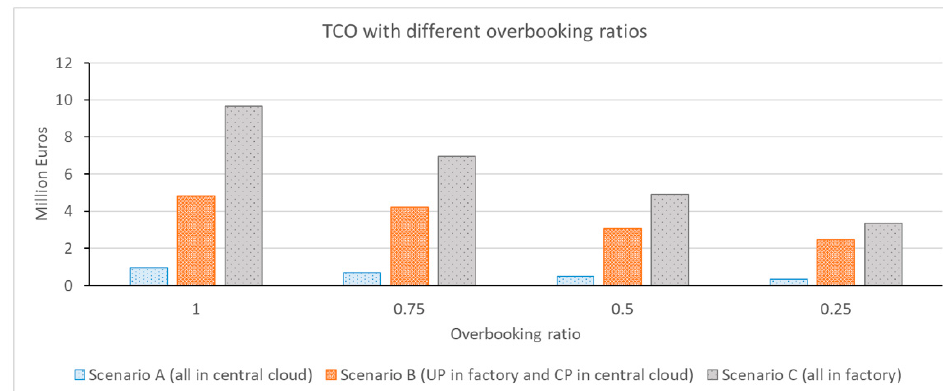
Figure 12. TCO comparison with different overbooking ratios and deployment scenarios.